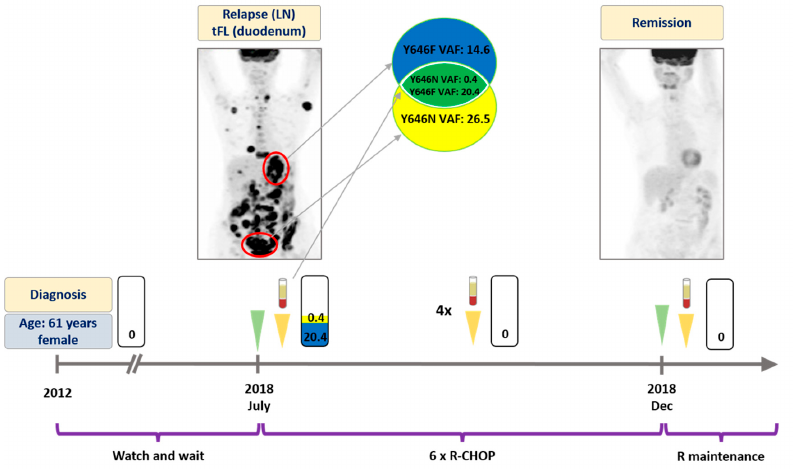
Figure 1. Detailed illustration of treatment monitoring in Patient #1. Spatial heterogeneity was captured in pretreatment plasma and rapid elimination of EZH2 Y646N and Y646F mutations was observed upon successful R-CHOP treatment. Since then the patient has been receiving rituximab maintenance therapy with good general health conditions. Numbers in the rectangles represent the VAF of the mutations, yellow color and blue colors indicate Y646N and Y646F variants, respectively. Green arrows indicate the time when the PET scans were performed, yellow arrows indicate the time when liquid biopsy specimens were collected. LN: lymph node. tFL: transformed follicular lymphoma. VAF: variant allele frequency. R-CHOP: rituximab, cyclophosphamide, doxorubicin, vincristine, prednisone. R: rituximab. Genes 2020 , 11 , x FOR PEER REVIEW